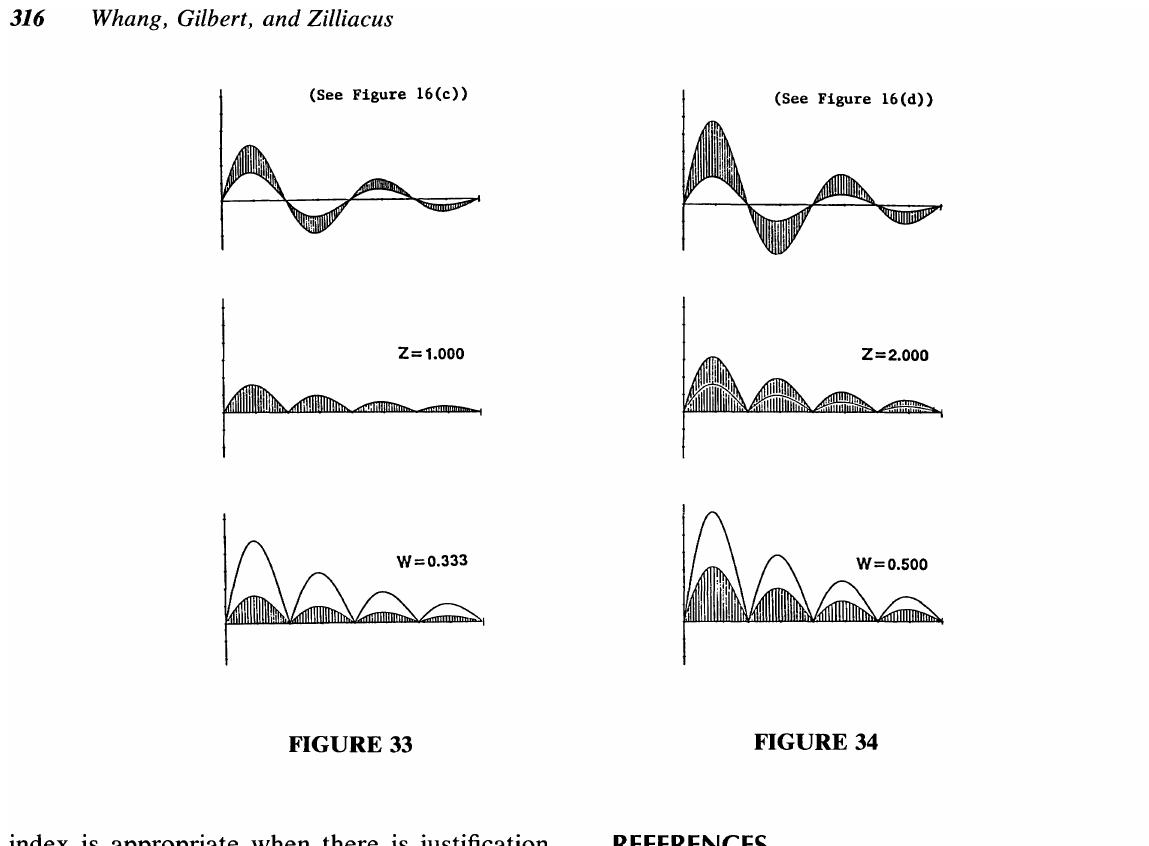
Dawson, R., October 1992, "A Comparison of Inter nal Fluid Model Experimental Data and Predicted Responses by Applying the Geers Error Function," CDNSWC Report SSPD-93-177-5. the Comparison of Calculated and Measured Tran sient Response Histories," Shock and